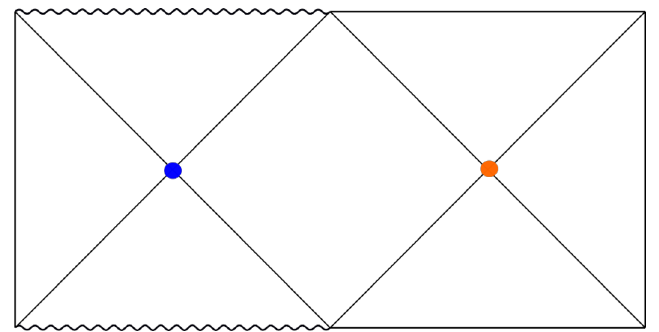
Figure 1 . The Penrose diagram of the black hole with the dilaton profile (3.4) ( ζ = 0 ). The blue dot is the event horizon of the black hole at θ = π , and the orange dot is the cosmological horizon at θ = 0 . In this work, we will use a somewhat nonstandard convention where θ increases from right to